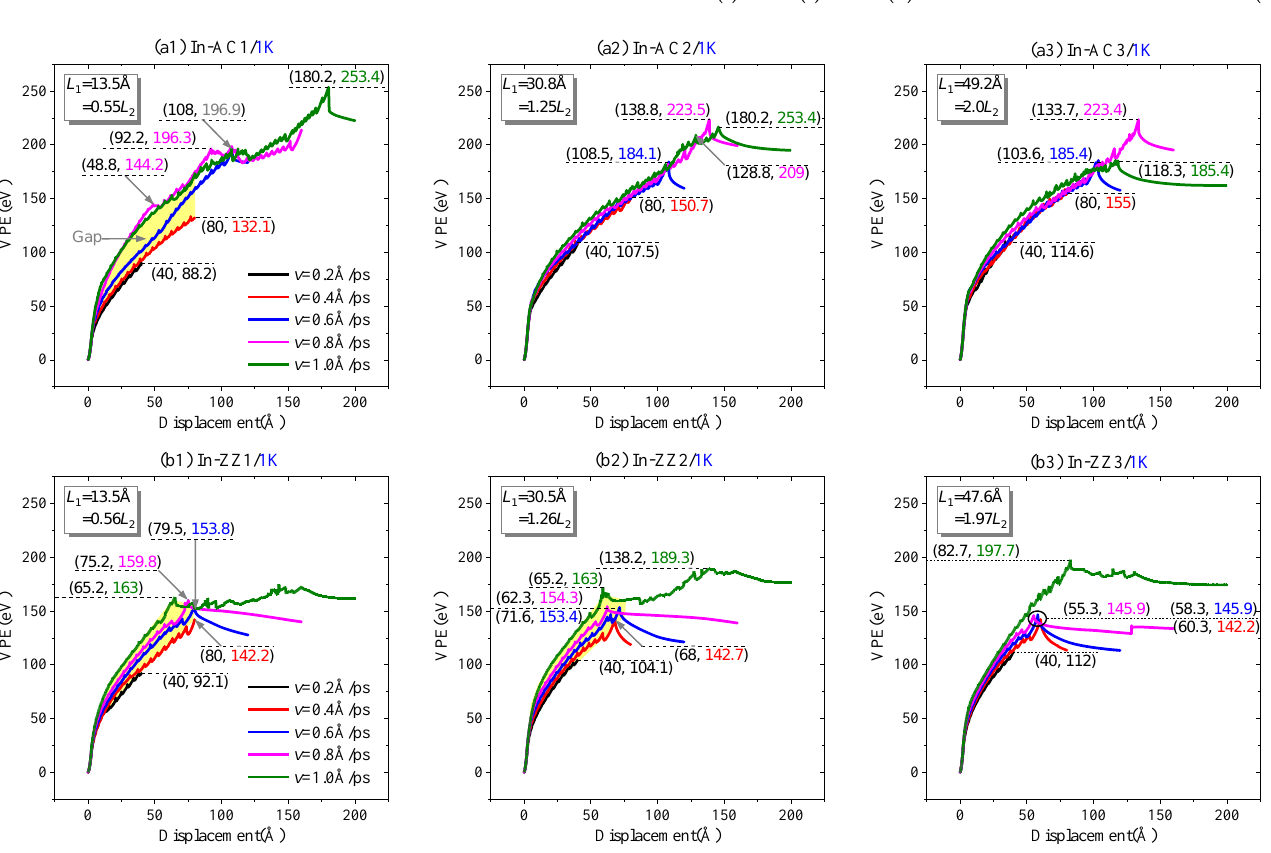
Figure 2. Curves of VPE vs. the tearing displacement, i.e., d , of a graphene sheet with three different aspect ratios at different tearing speeds within 200 ps at 1 K: ( a1 – a3 ) along the armchair crack, or ( b1 – b3 ) along the zigzag crack. Briefly, in a tearing process, VPE is determined by three factors, i.e., the number of broken C-C bonds (5~6 eV per atom [31]), the curvature of the deformed parts (with the bending stiffness of 0.1~0.4 eV/(nN · nm) [52]), and the overlap area of the deformed parts of the sheet ( − 0.04 eV per atom